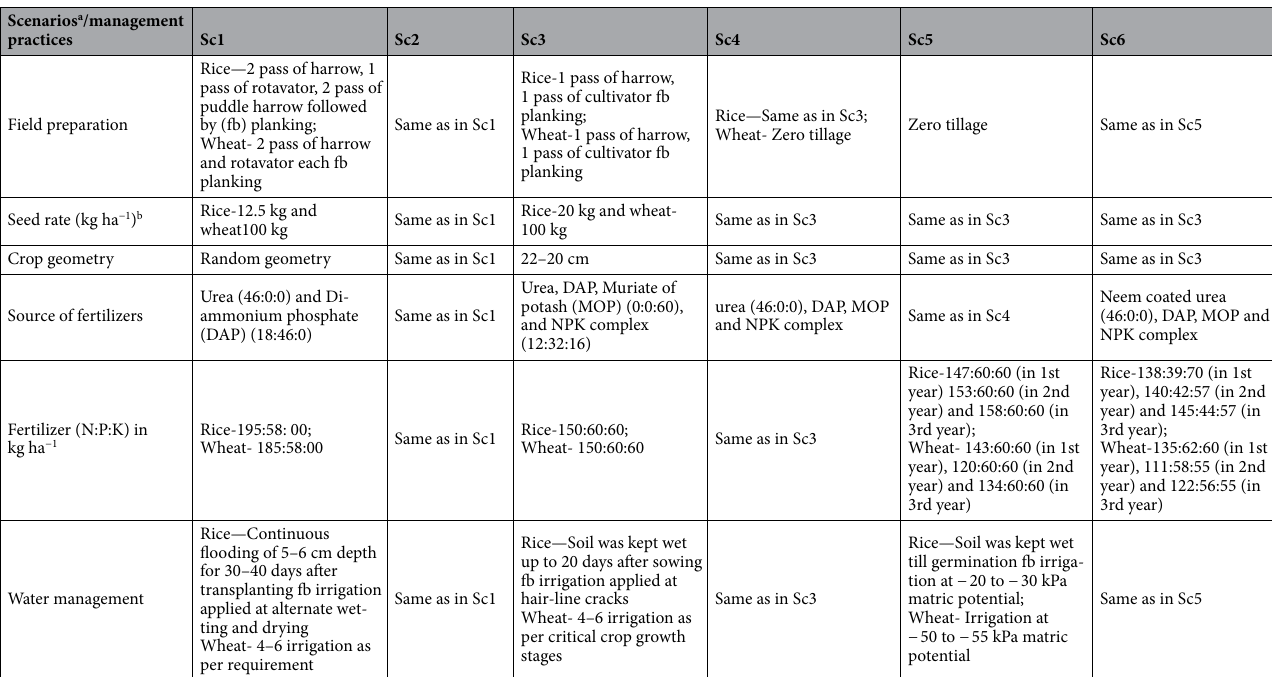
Table 5. Crop management practices for rice–wheat (RW) system under different scenarios. a Refer Table 4